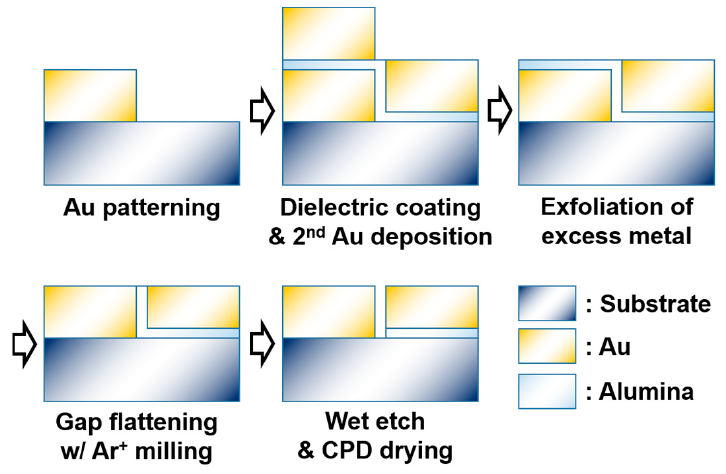
Figure 2. Fabrication scheme of the nano-trenches in a cross-sectional view. The nano-trenches before and after wet etching of the dielectric were analyzed with